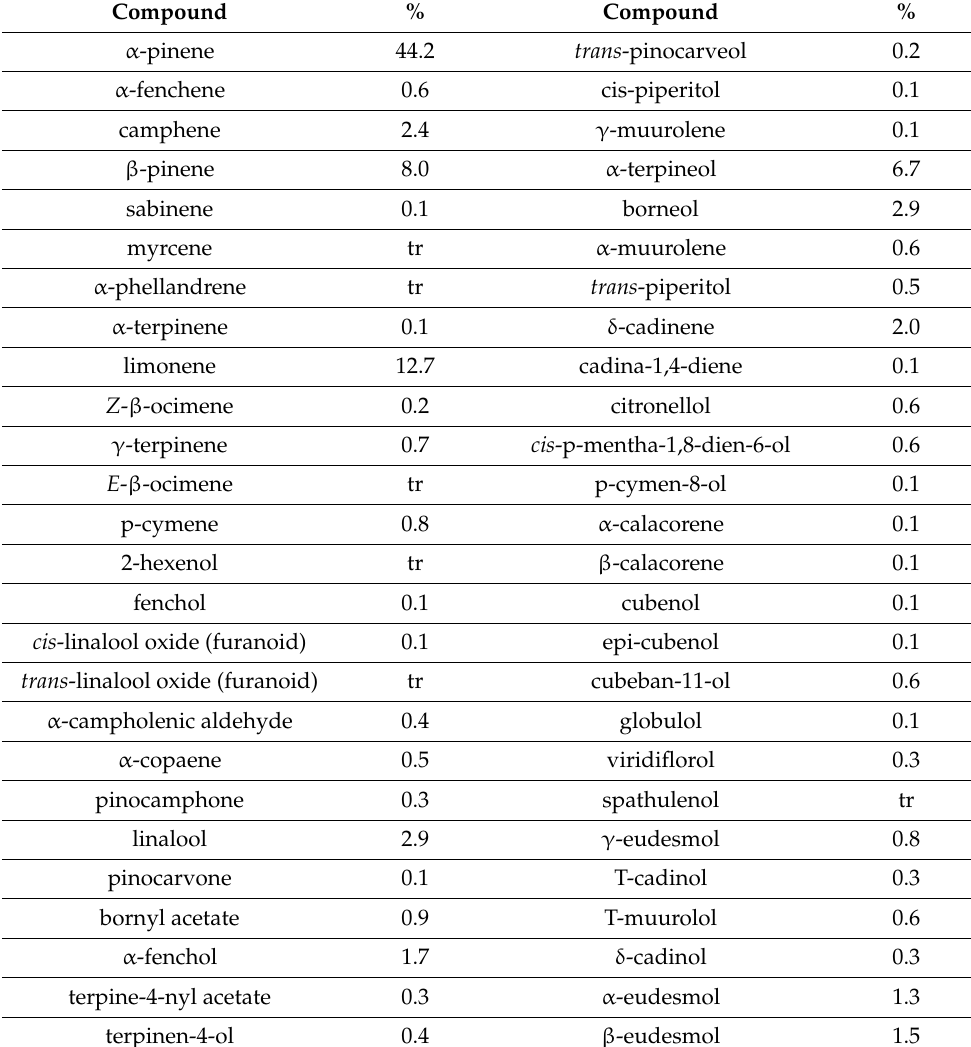
Table 12. Compounds identified in the leaf oil of Backhousia sciadophora